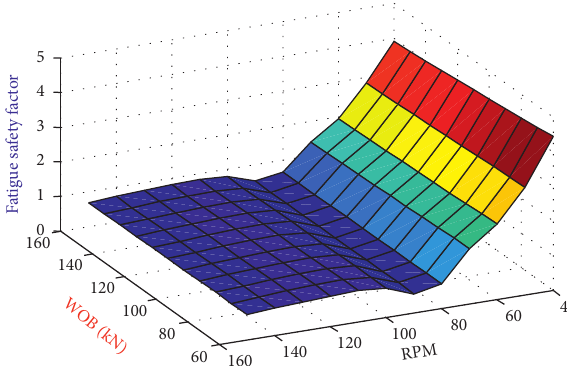
Figure 11: RPM-WOB-safety factor diagram of drilling tool (WOB: 60–160kN; RPM: 40–150rpm).